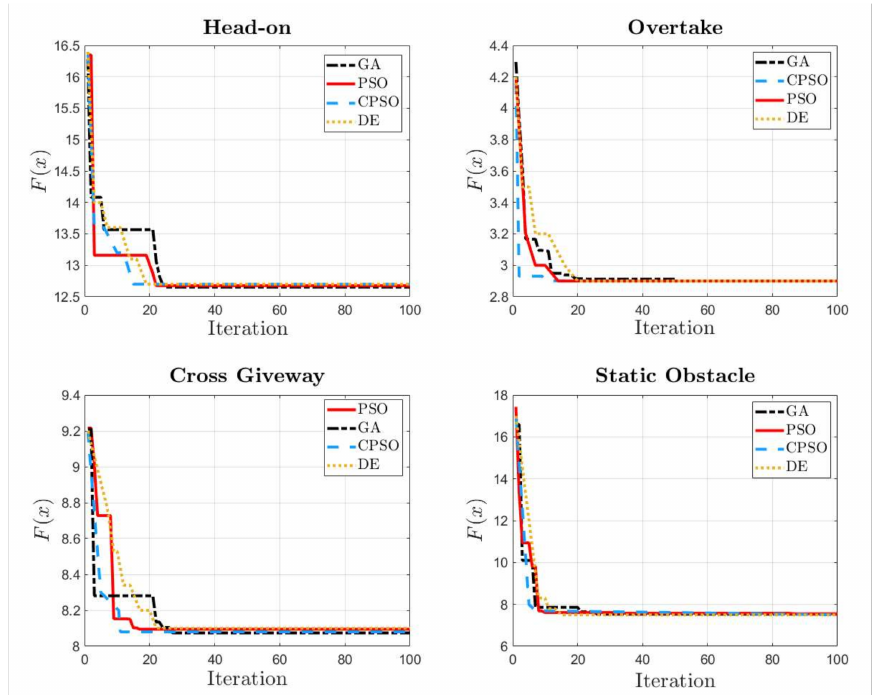
Figure 9. Convergence comparison of PSO, CPSO, GA and